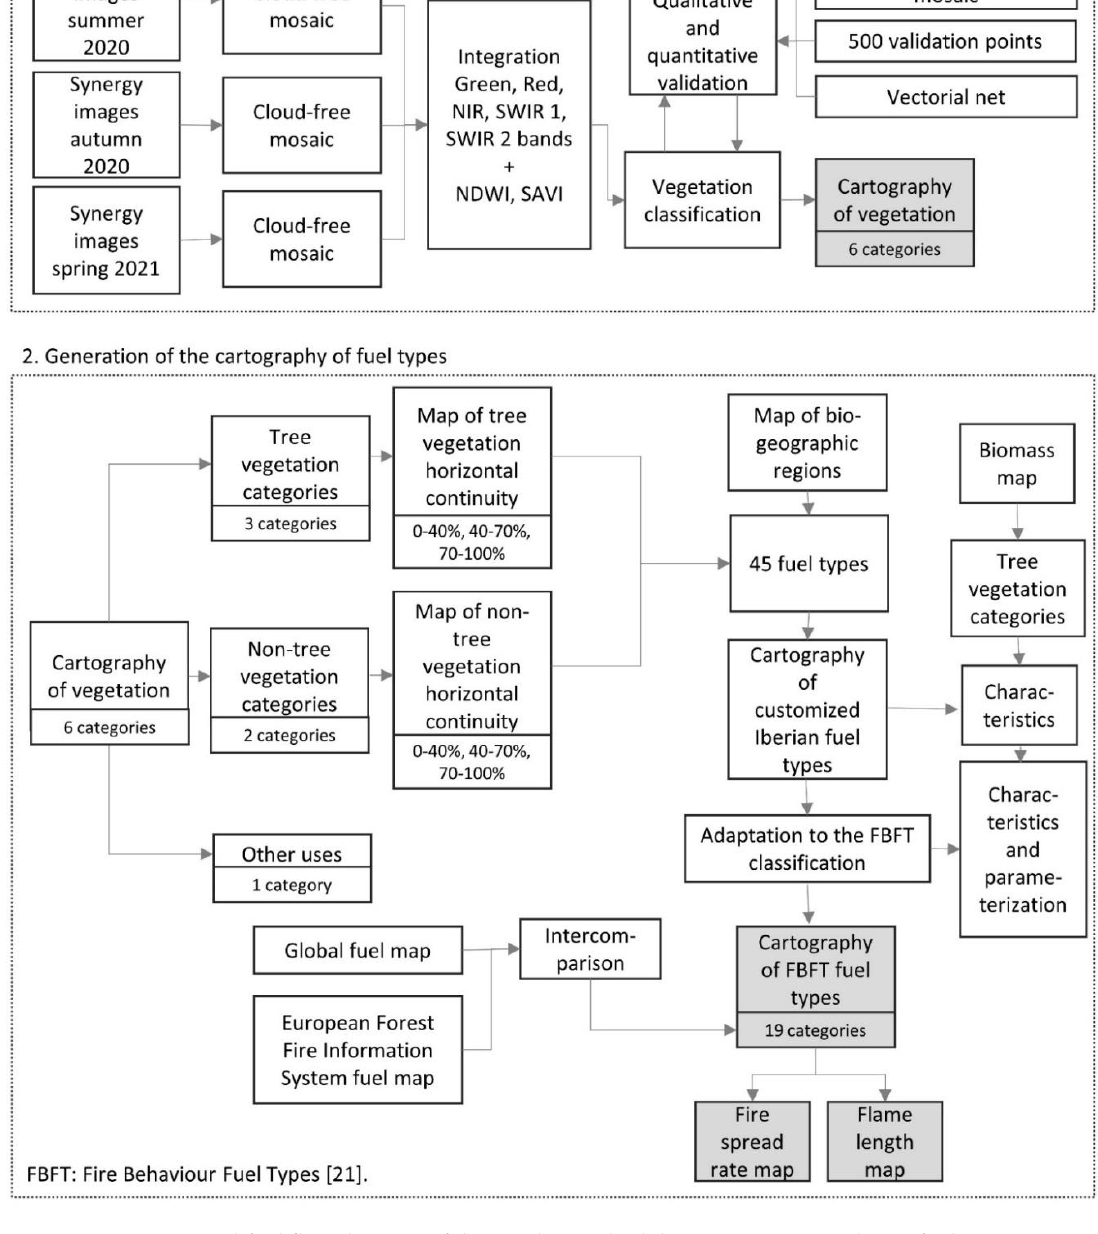
Figure 2. Simplified f low diagram of this work’s methodology to generate and map fuel